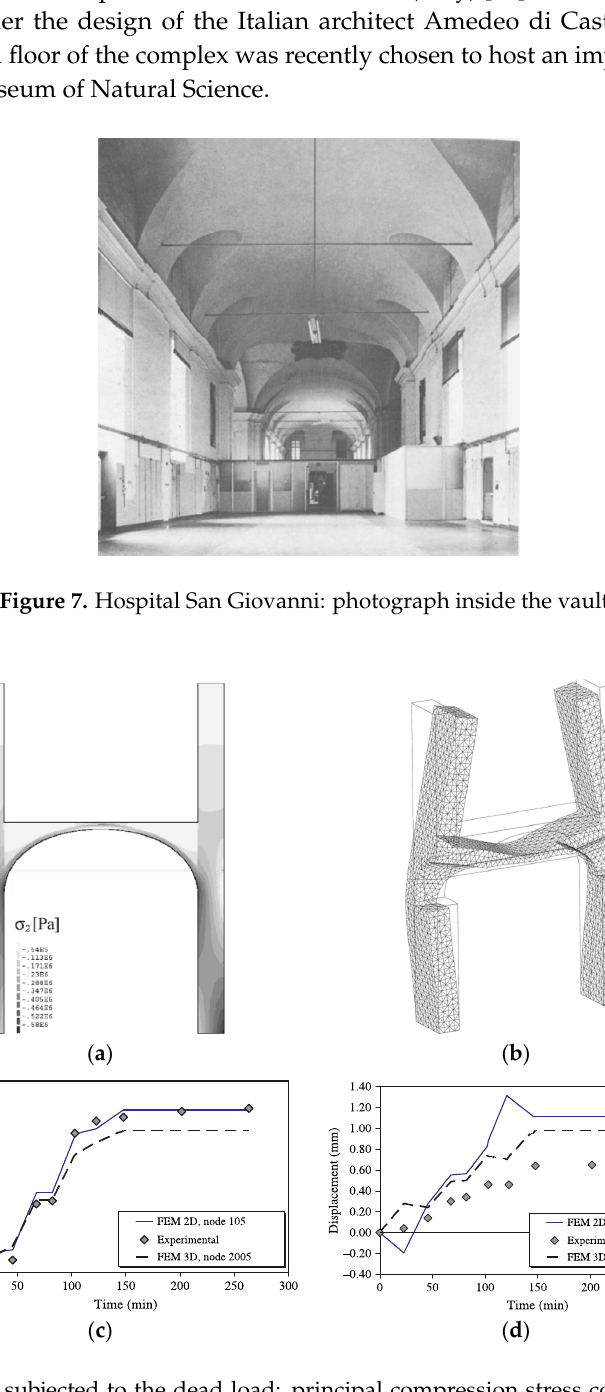
Figure 8. ( a ) Vault subjected to the dead load: principal compression stress contour; ( b ) 3D vault deformed mesh; ( c ) time ‐ displacement diagrams at the springing and ( d ) close to the keystone.